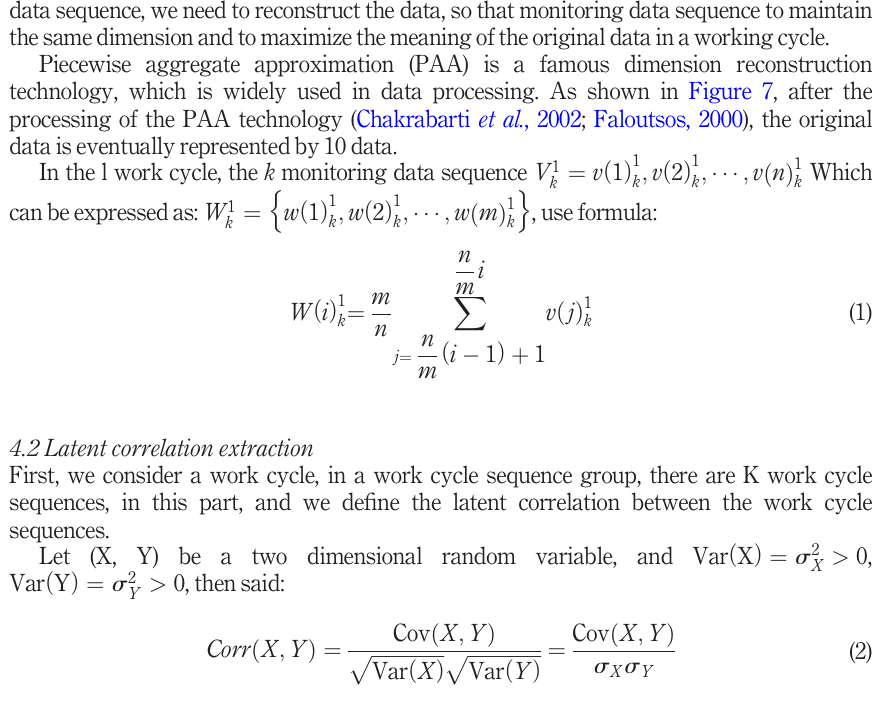
304050607080 01020 1 4 7